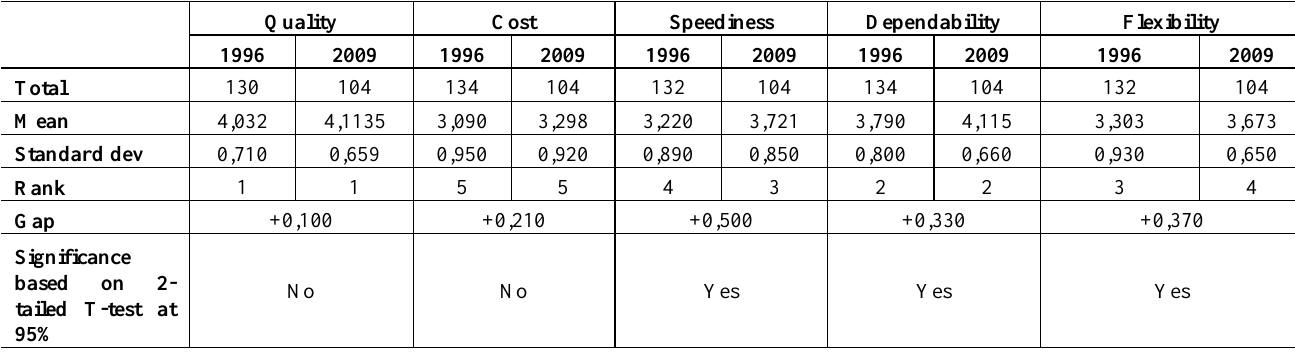
Table 11: Current strength and/or weakness 1996 vs 2009 Quality Cost